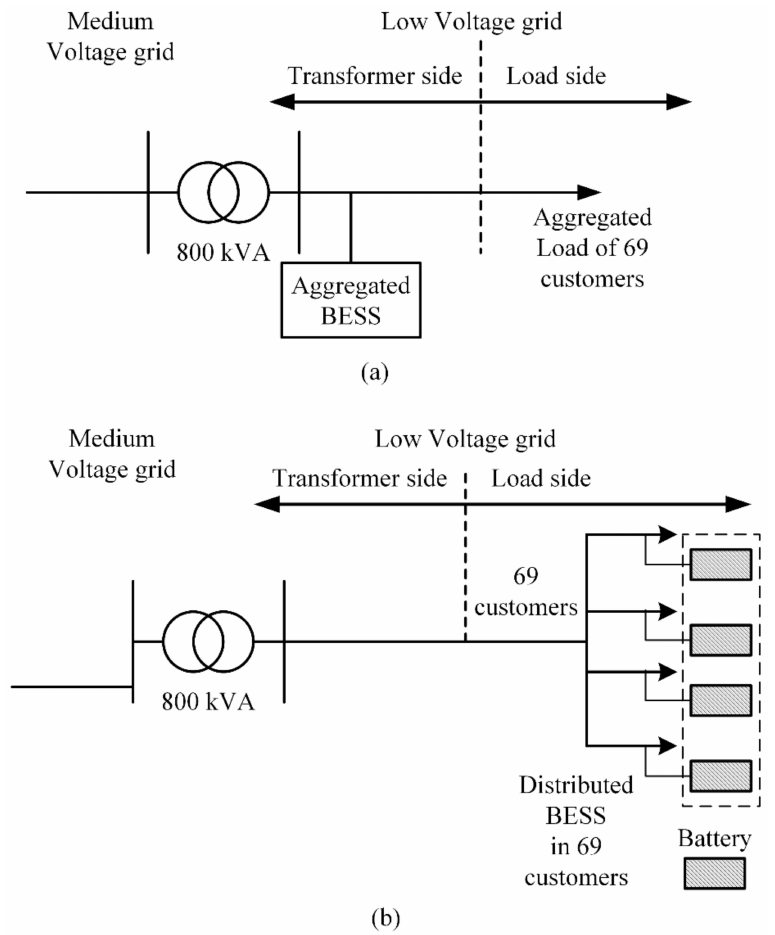
Figure 12. ( a ) An aggregated BESS that responds to the aggregated load and ( b ) a distributed BESS where each battery responds to its own associated